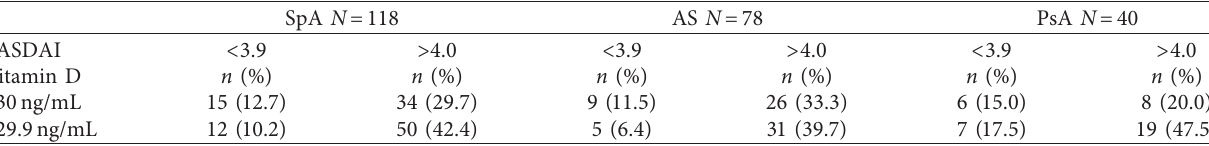
Table 2: Comparison between vitamin D serum levels and BASDAI in the spondyloarthritis (SpA), ankylosing spondylitis (AS), and psoriatic arthritis (PsA)